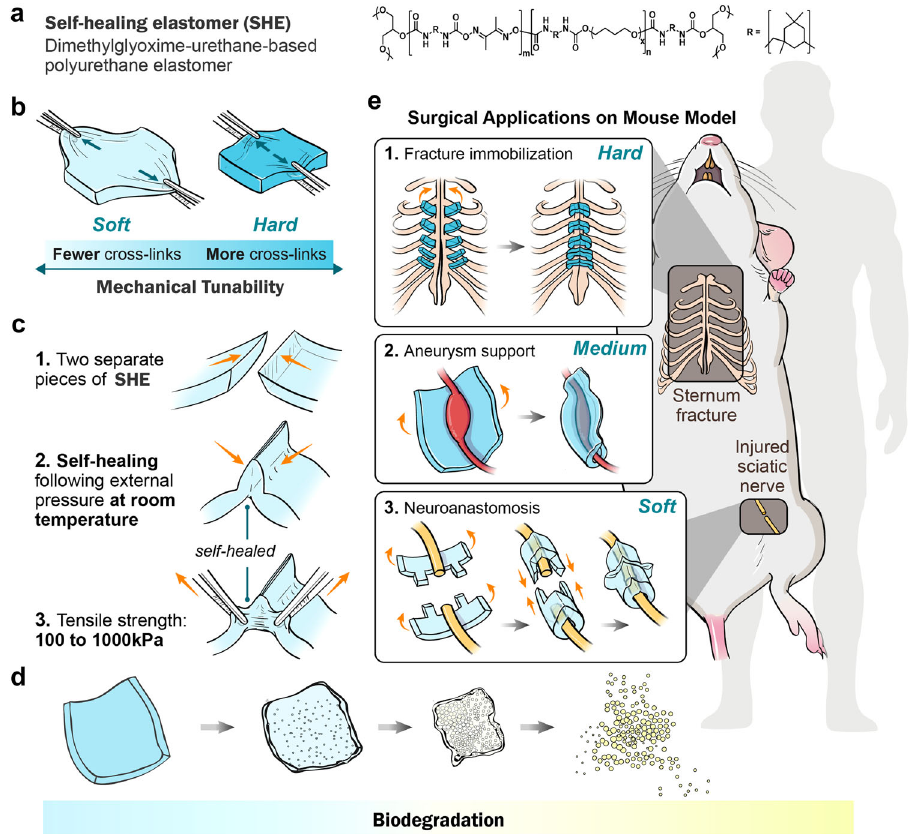
Fig. 1 Pattern diagram of chemical structural formula, tunable mechanical and self-healing properties, and in vivo biomedical applications of SHEs. a Abbreviation and full name of SHEs with its chemical structural formula. b Presentations of tunable mechanic by adjusting the degree of crosslink. c Pattern diagram of self-healing property of SHEs. d Pattern diagram of biodegradability of SHEs. e Three applications of SHEs in biomedical area in vivo. (From up to down) Fractured sternum bone immobilisation, wrapping aneurysm for limiting the progress, and LEGO-playing peripheral nerve coaptation. SHE self- healing